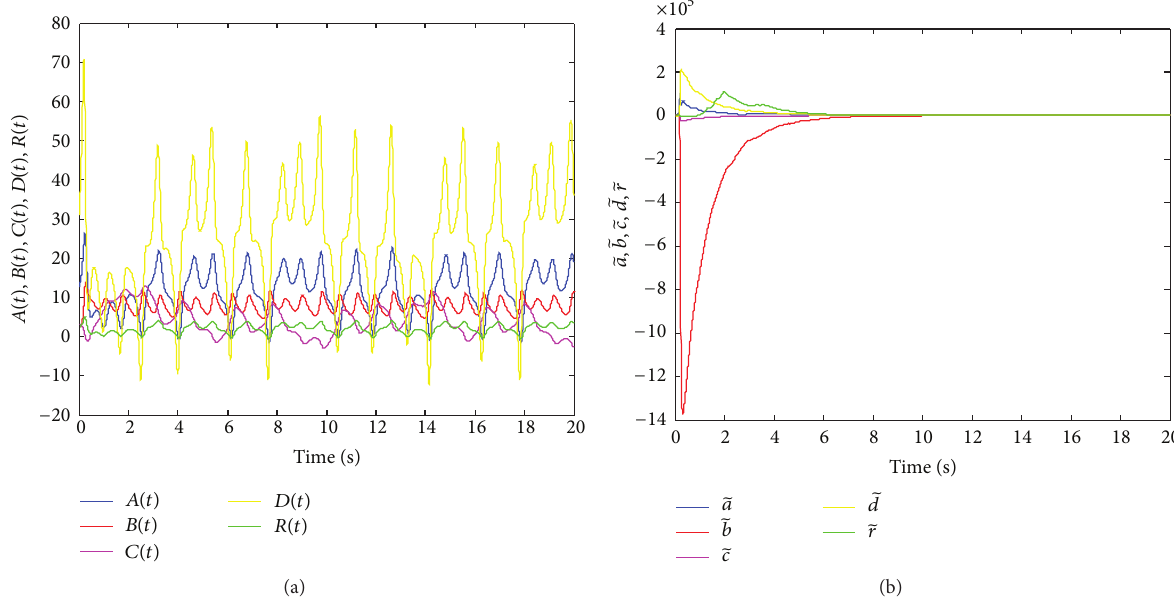
Figure 7: Time histories of 𝐴(𝑡) , 𝐵(𝑡) , 𝐶(𝑡) , 𝐷(𝑡) , and 𝑅(𝑡) and parameter differences for Case